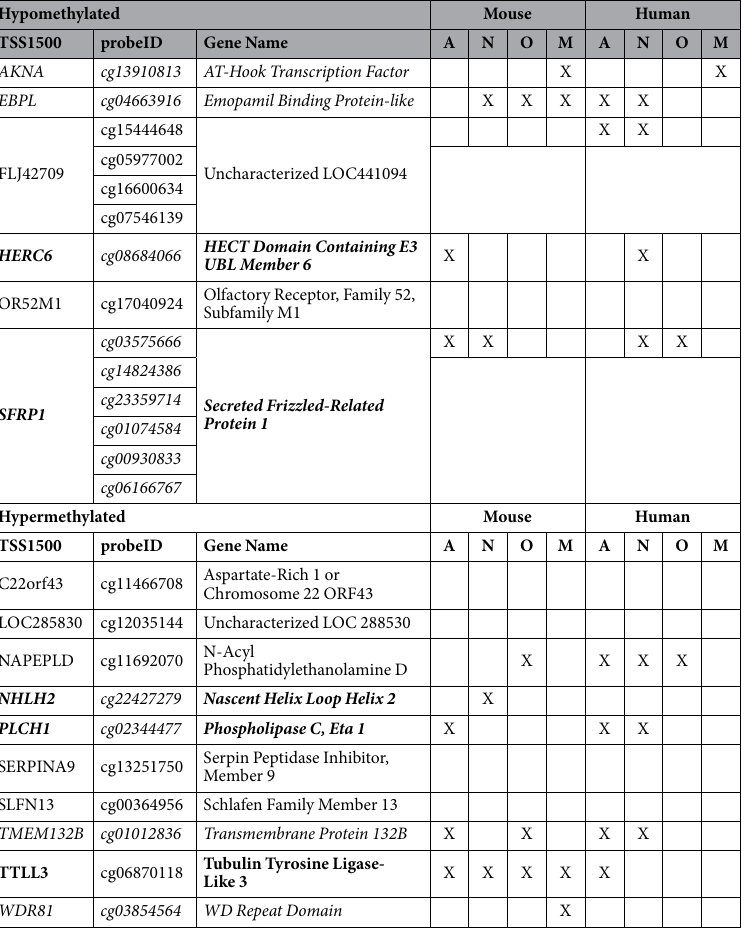
Table 3. Cellular Identity of hypo- and hyper-methylated CpGs near TSS in human and mouse. Genes where altered methylation was detected within 1500 bp were matched to corresponding cell types. Genes significantly altered in a comparison of MS hippocampus using previously published microarray-based analysis 5 are shown in bold. mRNA levels of genes measured using RT-PCR and presented in Figure 4 are